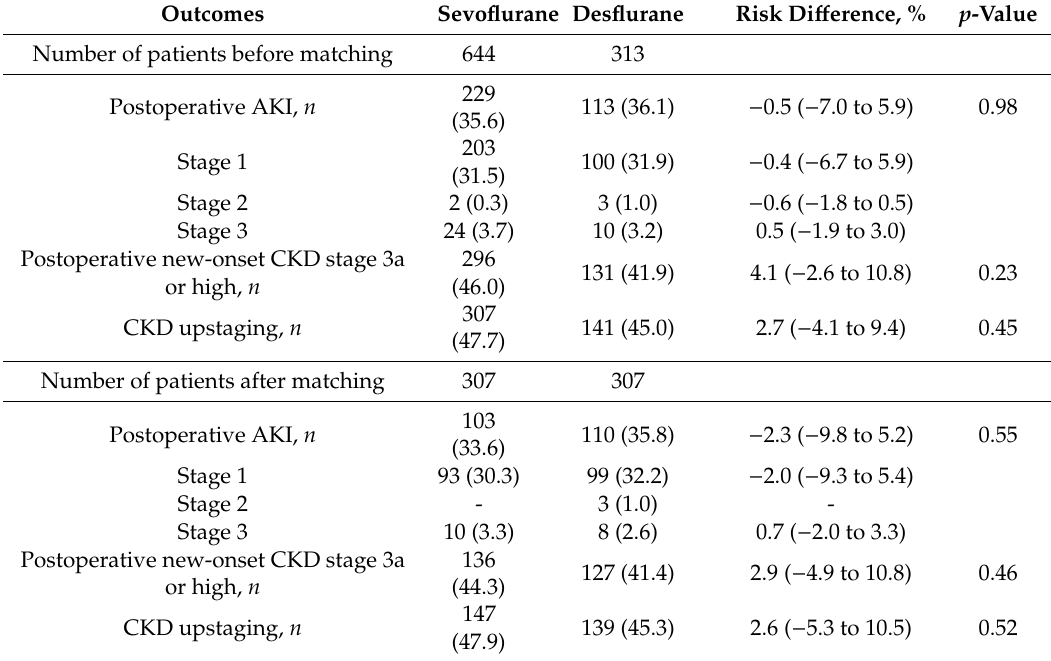
Table 4. Comparison of incidence of primary and secondary outcomes between patients according to the main anesthetic agents during surgery before and after propensity score